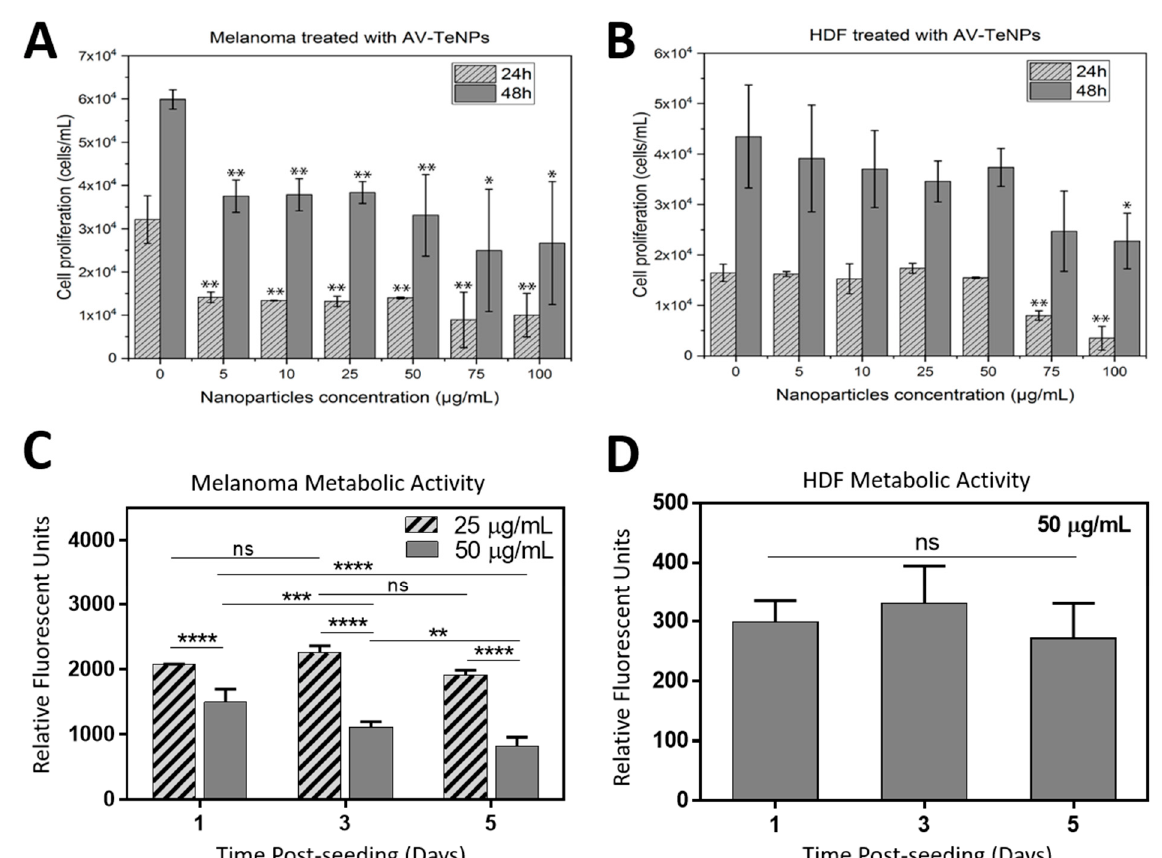
Figure 7. Melanoma ( A ) and human dermal fibroblast (HDF) ( B ) cells in the presence of AV-TeNPs at concentrations ranging from 5 to 100 µ g/mL. N = 3. Data is represented as mean ± SD; * p < 0.05, ** p < 0.01 compared to the control. ( C ) Melanoma cells treated with AV-TeNPs at two different concentrations of 25 and 50 µ g/mL. ( D ) Metabolic activity of HDF cells treated with AV-TeNPs at 50 µg/mL. Asterisks mark significance levels of p < 0.01 (**), p < 0.001 (***), and p < 0.0001 (****), ns = nonsignificant, and n = 5.